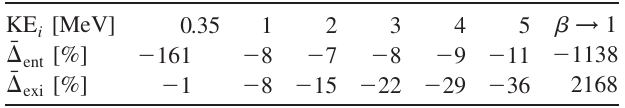
TABLE III. Relative quadrupole strength vs initial beam en- ergy. [MeV] KE i